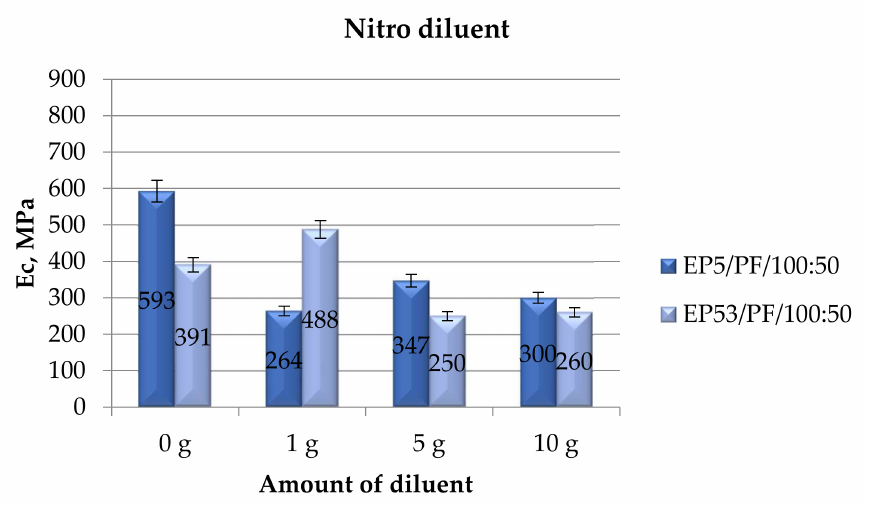
Figure 7. Compressive modulus calculated for Epidian 5 and Epidian 53 epoxy compounds as a function of the amount of nitro